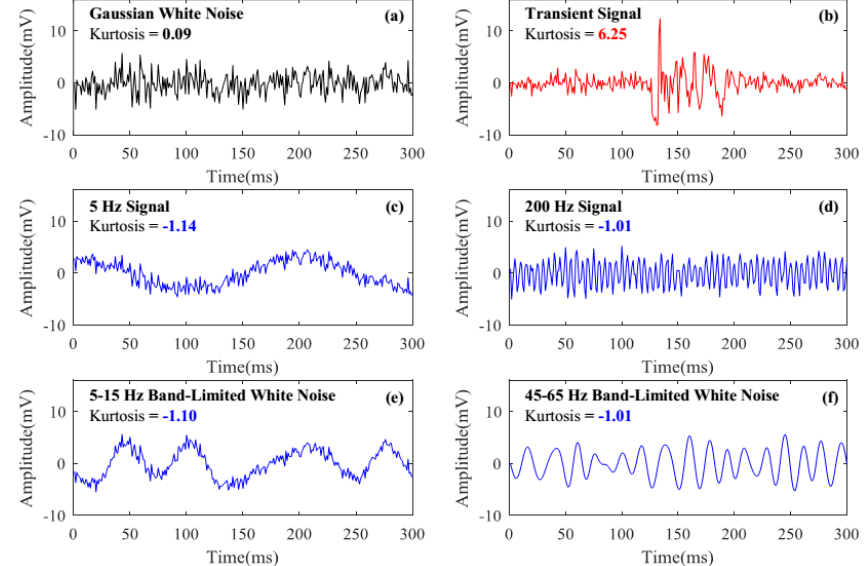
Figure 1. The simulated signals in phase-sensitive optical time-domain reflectometry ( Φ -OTDR) systems. ( a ) Gaussian noise; ( b ) Transient signal; ( c ) Signal with the frequency of 5 Hz; ( d ) Signal with the frequency of 200 Hz; ( e ) 5–15 Hz band-limited white noise; ( f ) 45–65 Hz band-limited white noise.